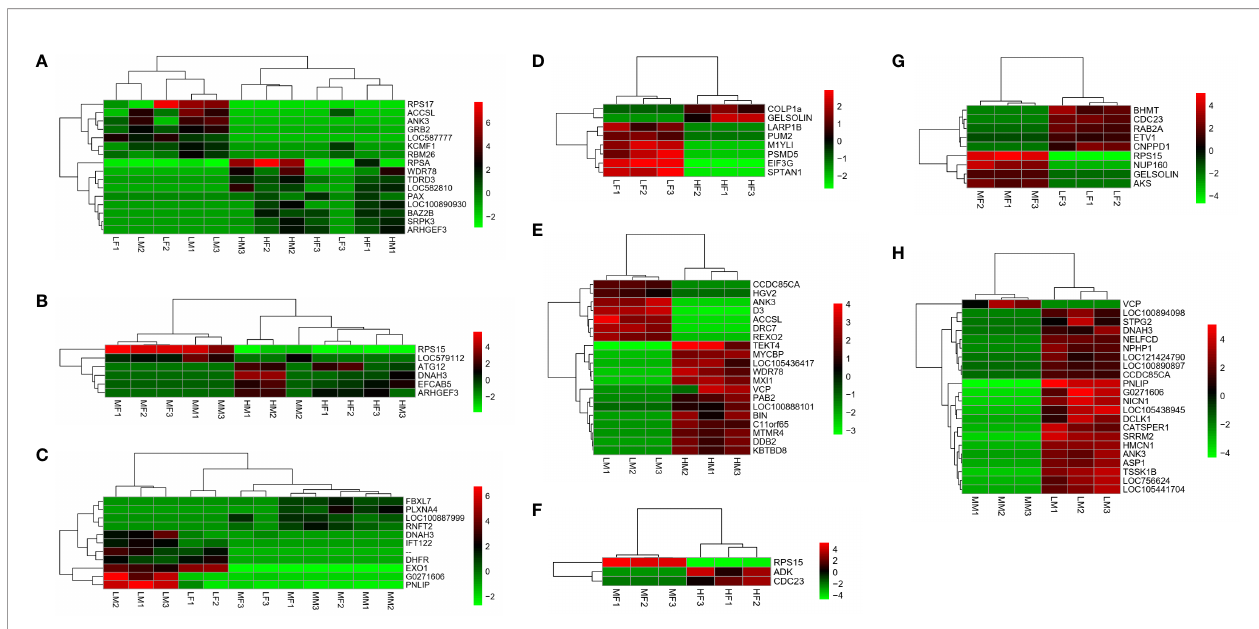
FIGURE 3 | Heatmaps based on differentially expressed genes from pairwise comparisons. Different colors indicate relative expression levels. (A) H vs L; (B) H vs M; (C) M vs L; (D) HF vs LF; (E) HM vs LM; (F) HF vs MF; (G) LF vs MF; (H) LM vs MM. Sample name explanation: H ” - high concentration of PUFA in both sexes of sea urchin; “ M ” - medium concentration of PUFA in both sexes; “ L ” -low concentration of PUFA in both sexes; “ HF ” - high concentration of PUFA in ovaries of female sea urchins; “ HM ” - high concentration of PUFA in testes of male sea urchins; “ MF ” - medium concentration of PUFA in ovaries; “ MM ” - medium concentration of PUFA in testes; “ LF ” - low concentration of PUFA in ovaries; “ LM ” - low concentration of PUFA in testes. The number (1, 2, 3) means three